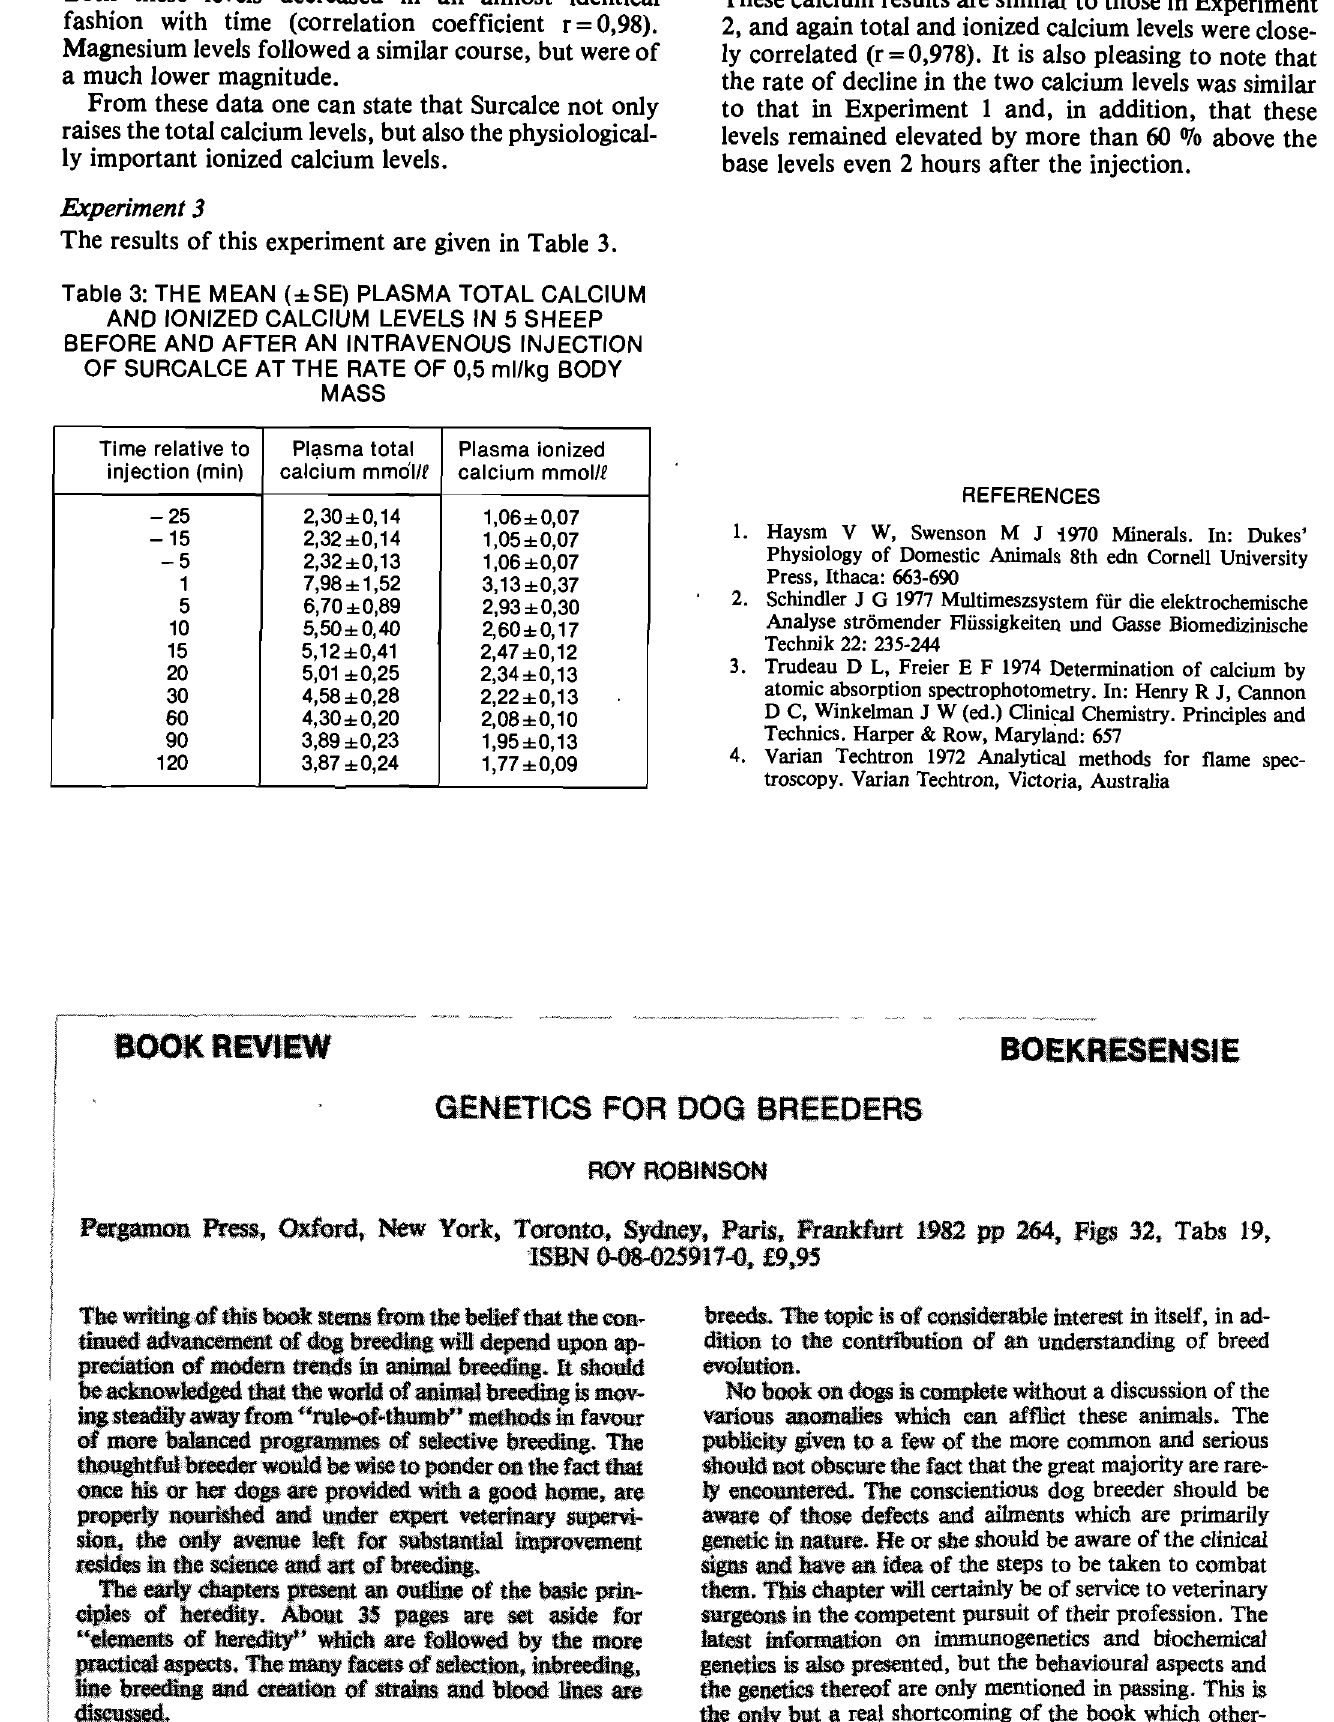
Table 3: THE MEAN (±SE) PLASMA TOTAL CALCIUM AND IONIZED CALCIUM LEVELS IN 5 SHEEP BEFORE AND AFTER AN INTRAVENOUS INJECTION OF SURCALCE AT THE RATE OF 0,5 ml/kg BODY MASS Time relative to Plasma total Plasma ionized injection (min) calcium